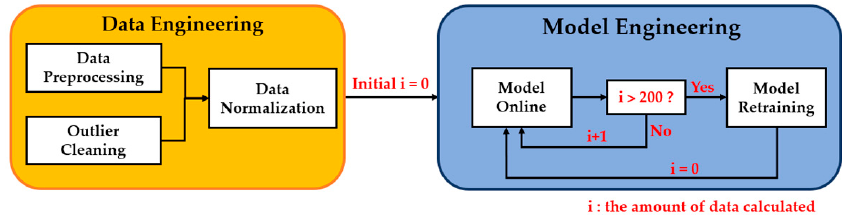
Figure 15. Retraining flow chart for the ensemble gas model.